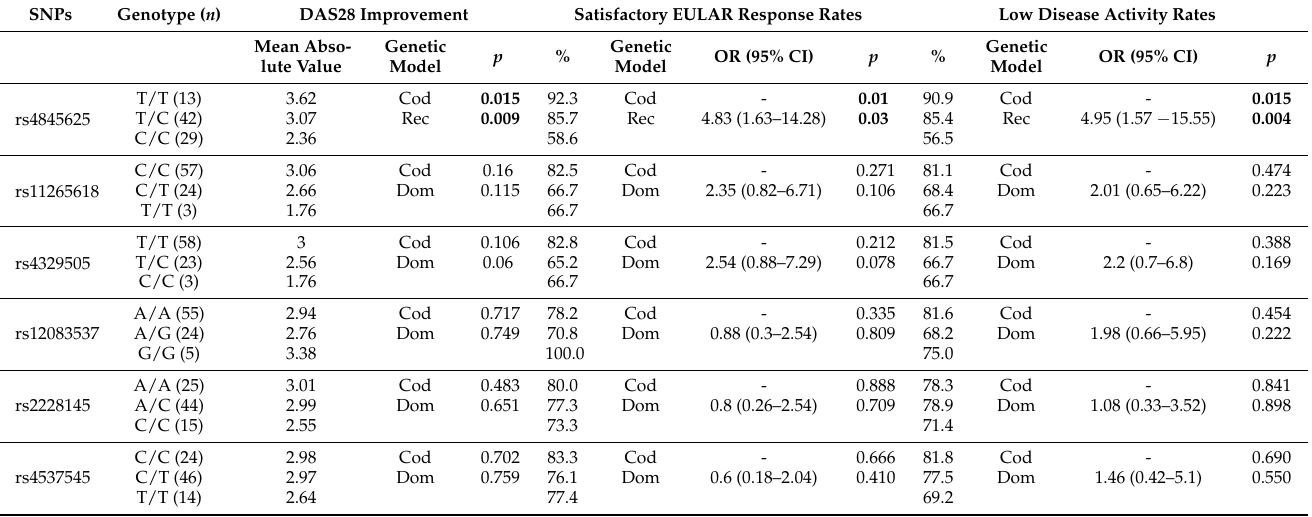
Table 3. Associations between the considered SNPs and response outcomes at 6